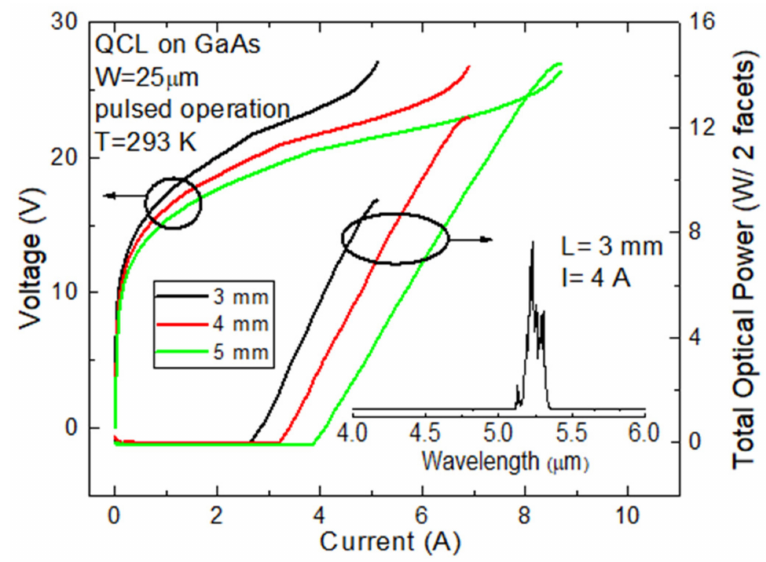
Figure 3. Electrical and output power characteristics for different cavity lengths as a function of current. Inset shows emitting spectra of the 3 mm long laser at a pulsed current of 4